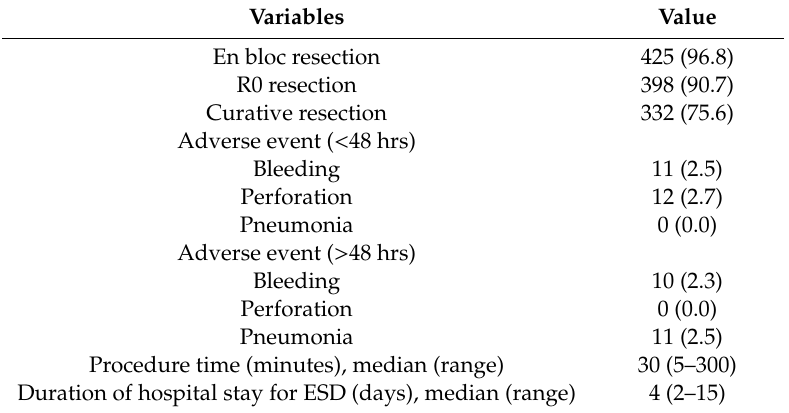
Table 3. Short-term clinical outcomes of endoscopic submucosal dissection for the 439 elderly patients.